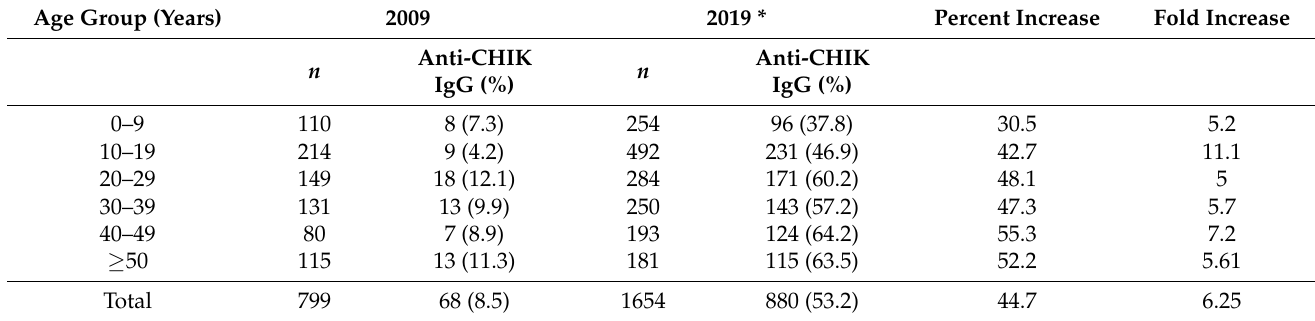
Table 1. Comparison of age-stratified seroprevalence of CHIKV infection in Pune City in 2009 and